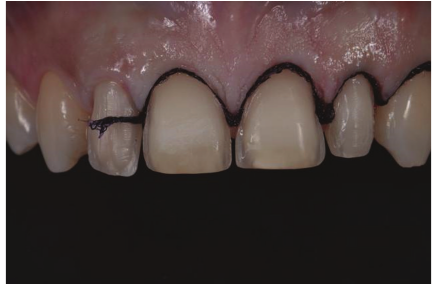
Figure 4: CAD design of the mockup.